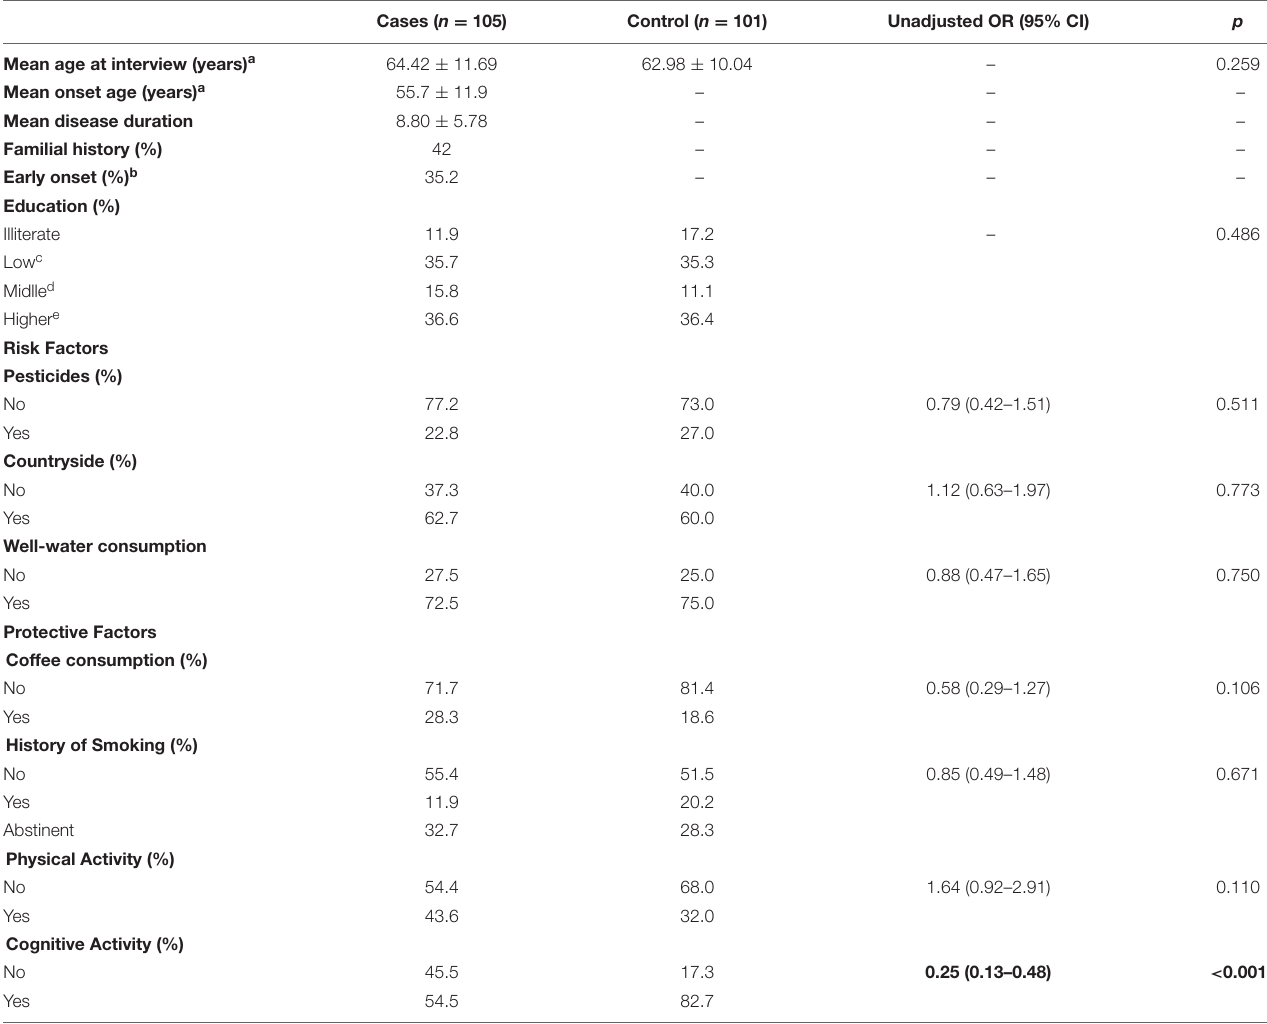
TABLE 1 | Profile and frequencies of exposition to environmental